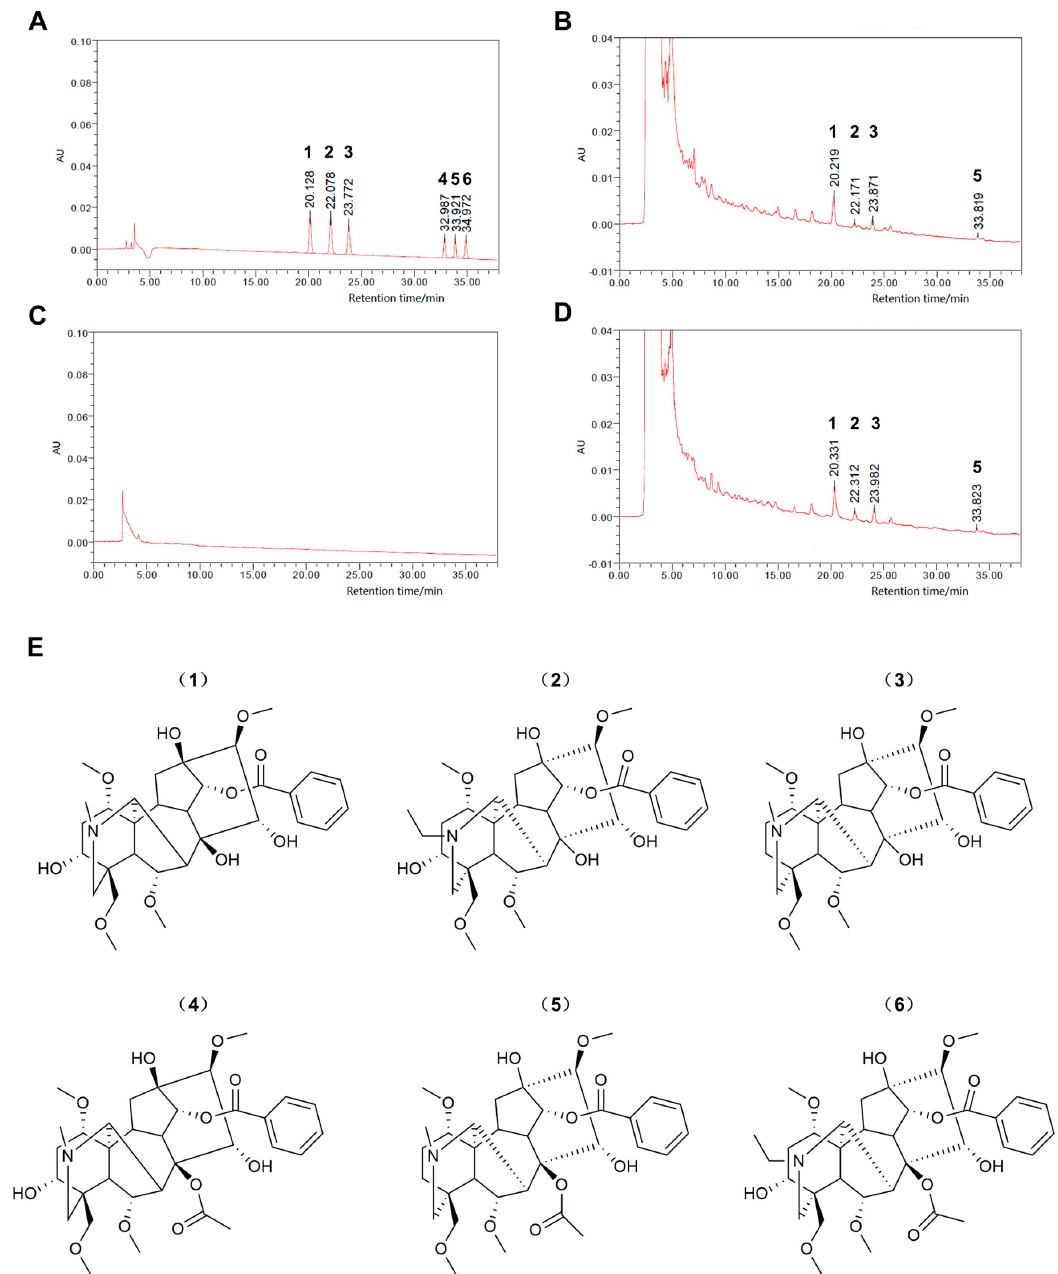
Figure 1. Standardization analysis of Radix Aconiti Lateralis Preparata extracts. HPLC chromatogram of ( A ) reference substances, ( B ) Radix Aconiti Lateralis Preparata extract, ( C ) fuzi polysaccharides, and ( D ) fuzi total alkaloid samples. ( E ) Chemical structure of the six reference substances. 1 , benzoylmesaconine; 2 , benzoylaconine; 3 , benzoylhypacoitine; 4 , mesaconitine; 5 , hypaconitine; 6 ,